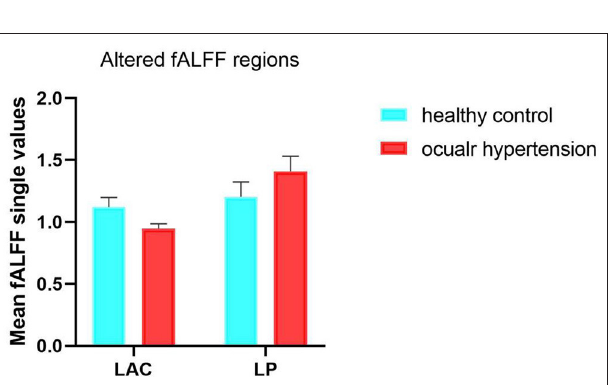
FIGURE 3 | Mean ALFF values between the OH and HC groups in the different regions of the brain. fALFF, fractional amplitude of low-frequency fluctuations; ALFF, amplitude of low-frequency fluctuations; OH, ocular hypertension; HC, healthy control; LAC, left anterior cingulate; LP, left